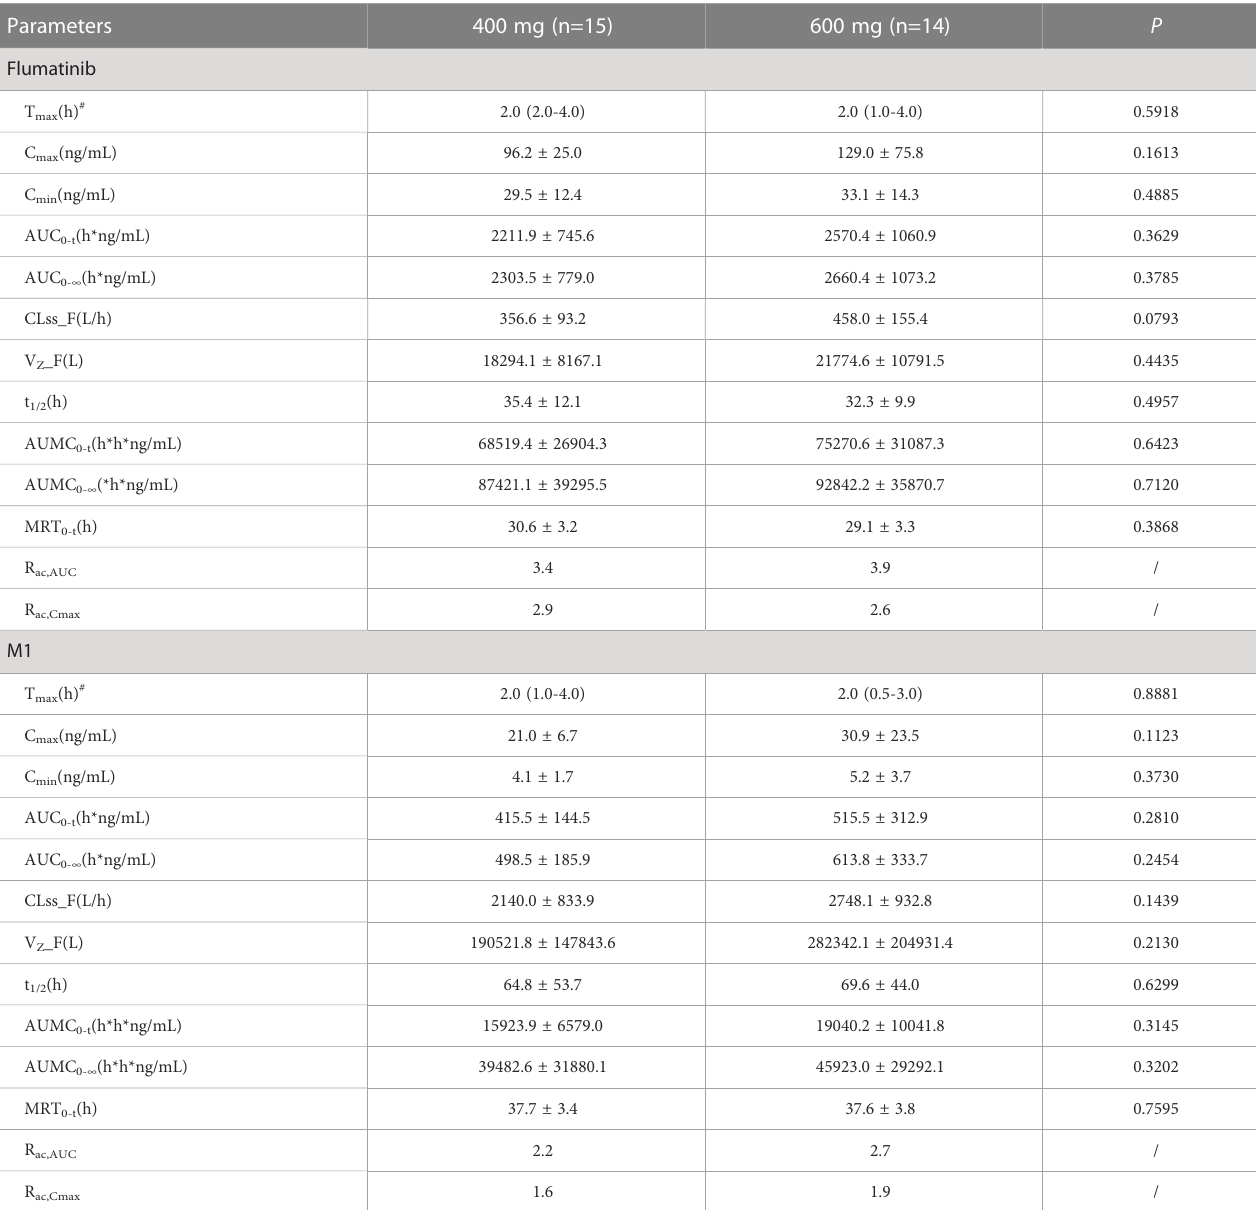
TABLE 3 Pharmacokinetic parameters of fl umatinib and two major metabolites following a multiple-dose administration.